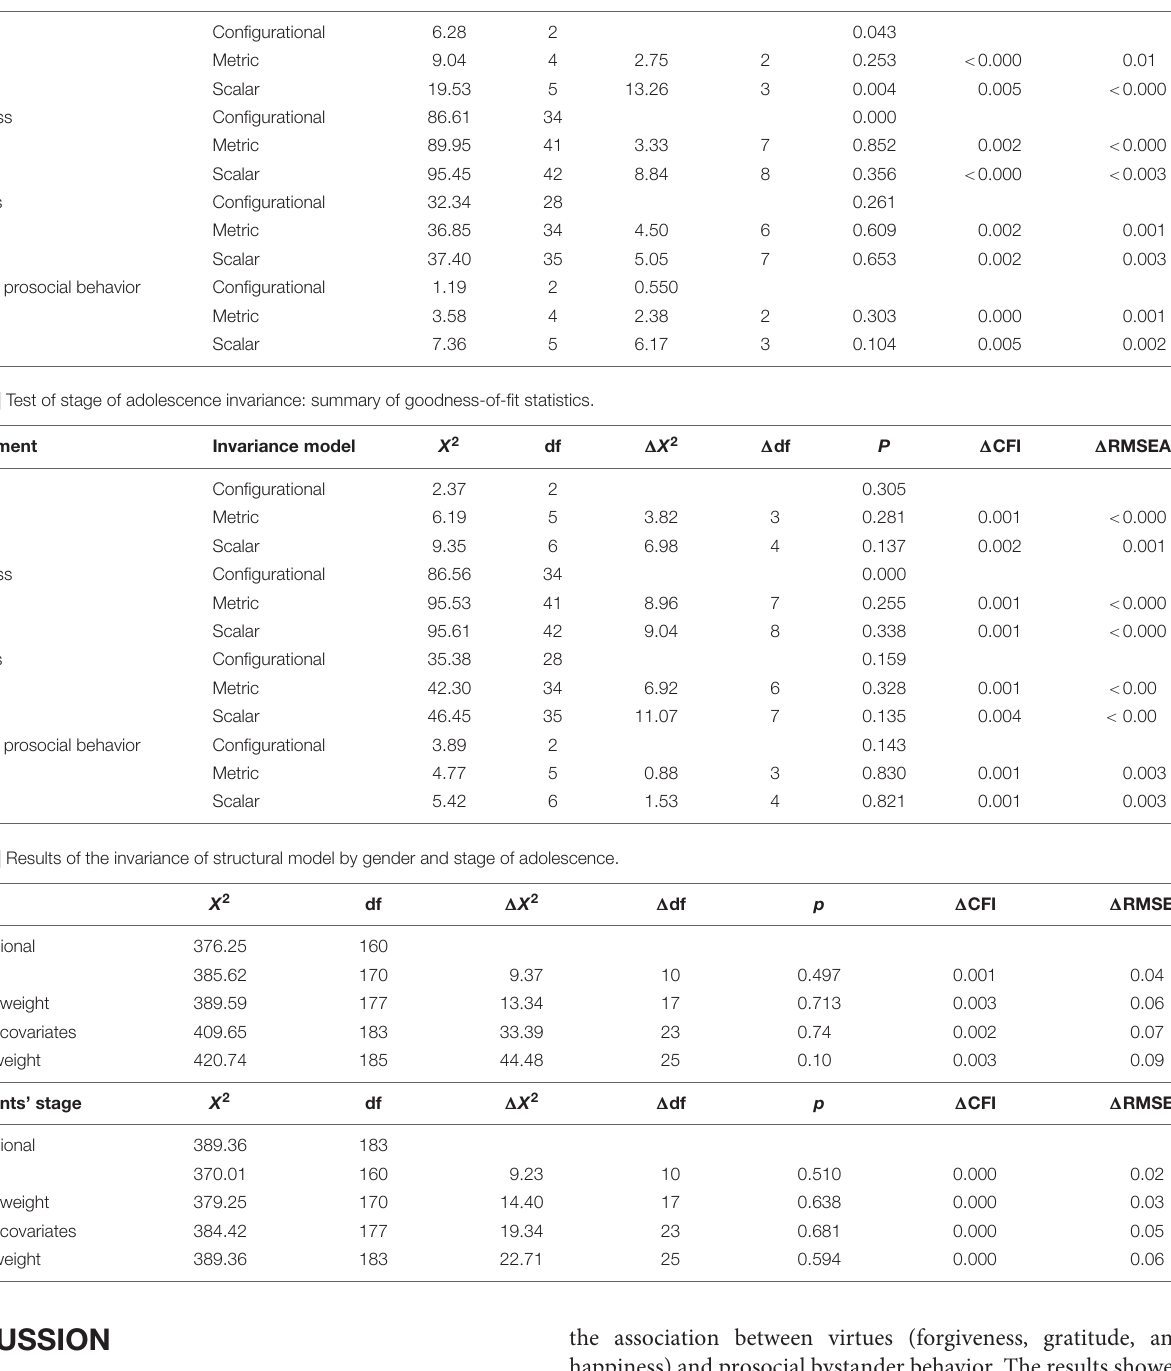
TABLE 2 | Test of gender invariance: summary of goodness of-fit statistics. Measurement